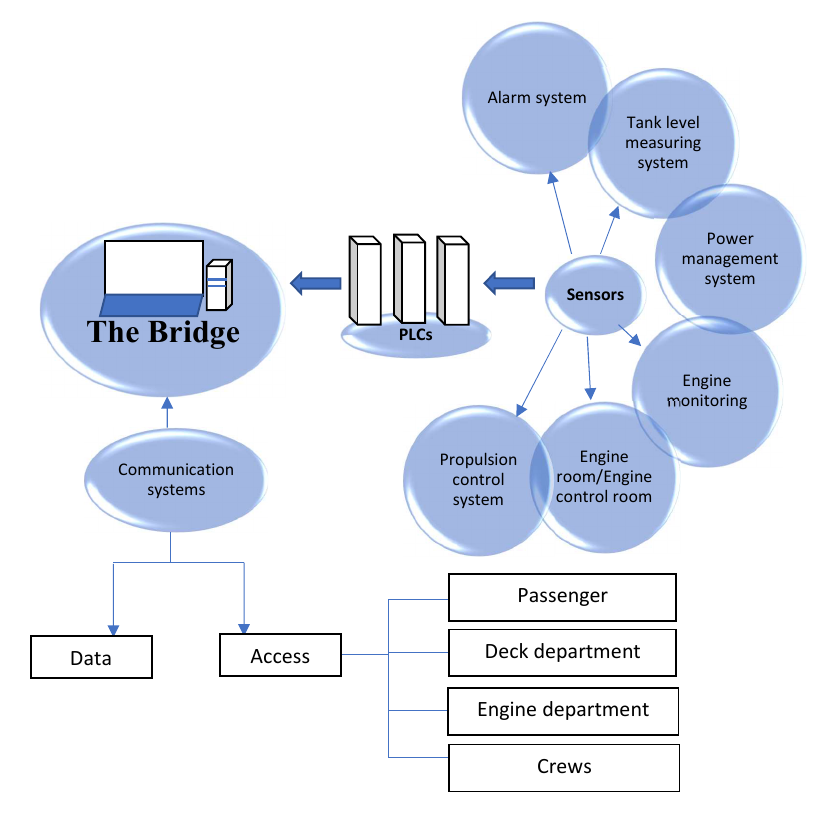
Figure 4. Vessel elements